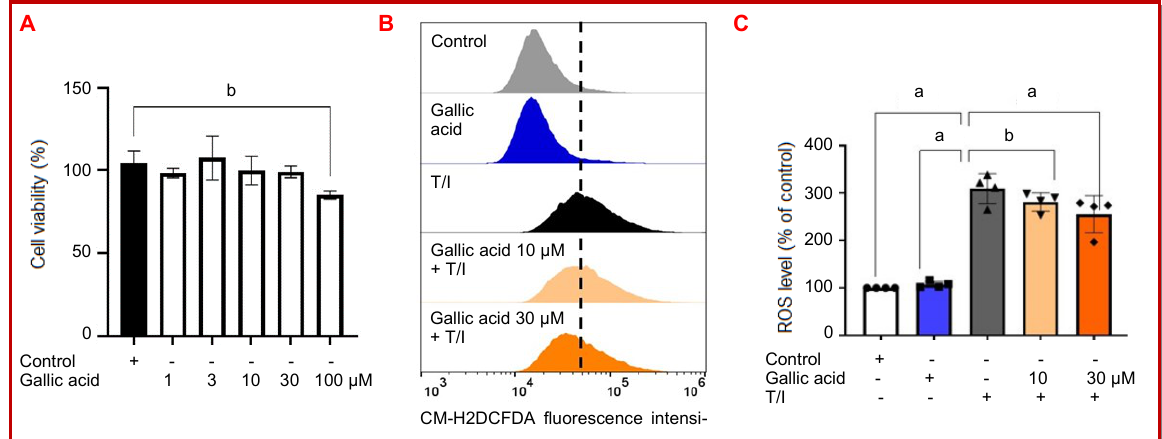
Figure 1: Effect of gallic acid on the viability of HaCaT keratinocytes (A) and ROS generation (B,C). HaCaT cells were treated with various concentrations of gallic acid or vehicle (control) for 24 hours. Cell viability was determined using the MTT assay. ROS generation in HaCaT cells was detected by CM-H2DCFDA staining and quantified via flow cytometry. HaCaT cells were treated without (control) and with different concentrations of gallic acid in the presence of 10 ng/mL recombinant human TNF- α and 10 ng/mL IFN- γ (T/I) for 24 hours. Data are presented as a percentage of control group values (mean ± SD of three independent experiments). a p<0.0001 and b p<0.05 indicate a significant difference